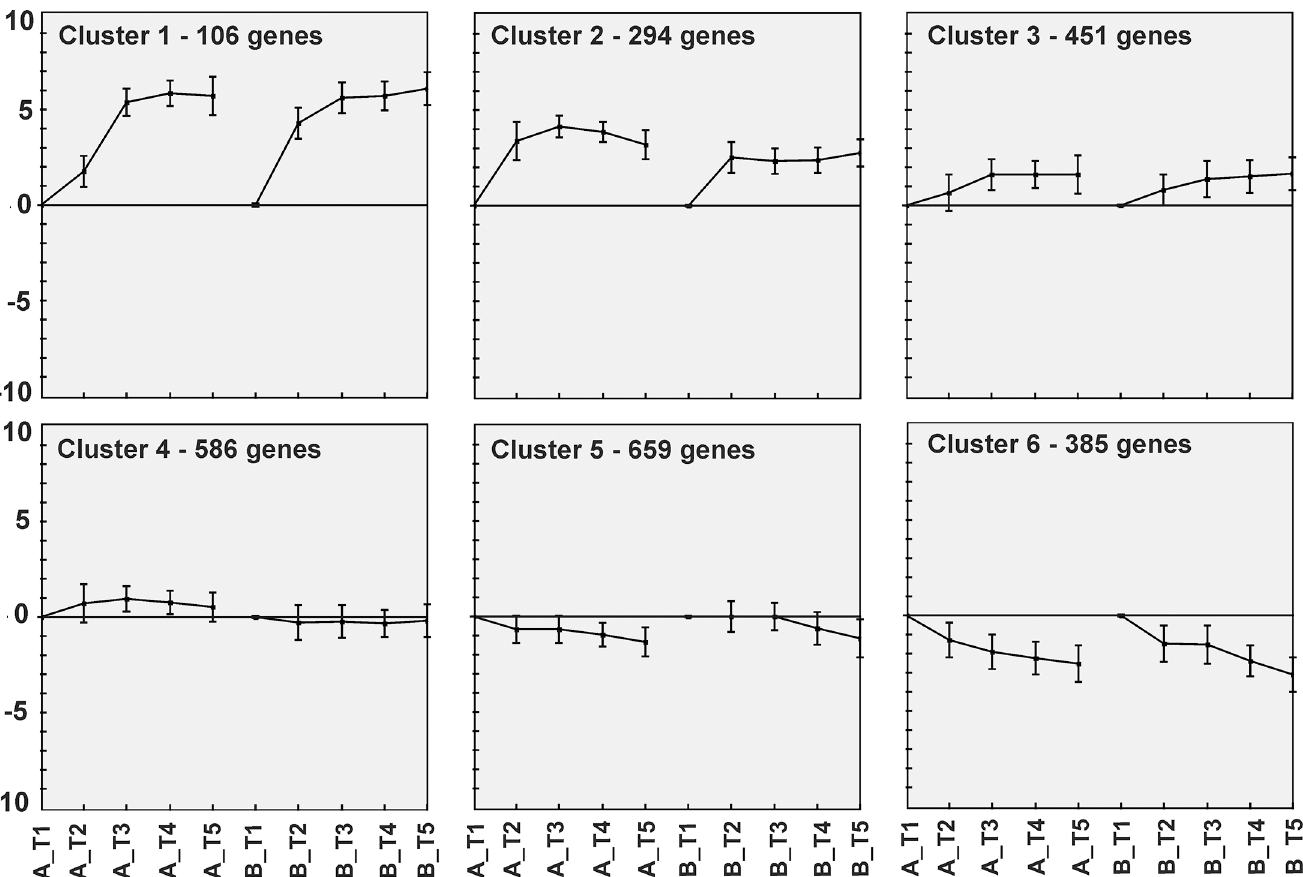
Fig 4. Results of k -means clustering of whole-genome expression profiles. Six clusters were generated based on comparison of point-wise similarity of genome-wide gene expression profiles during the sporulation time course with Euclidean distance (Genesis v 1.7.6). The samples collected at representative time points (T 1 -T 5 ) of independent experiment duplicates (A and B) were equally weighted (see Methods and Materials). The data points show the average log 2 -transformed expression compared to exponential phase (T 1 ) of all cluster members, with standard deviation indicated by the error